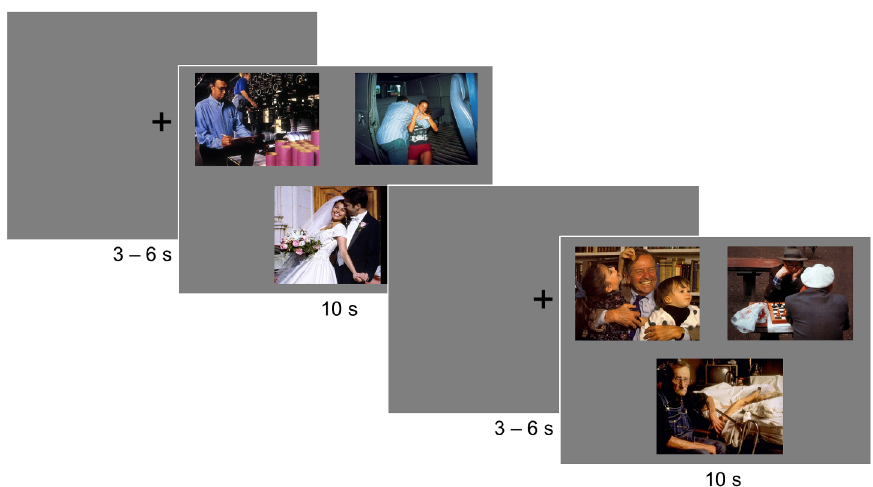
Figure 1. Outline of the eye-tracking paradigm. Two consecutive trials are presented, each starting with a fixation cross, followed by a display of a positive, negative and neutral social scene. The first trial includes social scenes that depict young adults in age-typical scenes, while images of the second example trial belong to the old-age category.